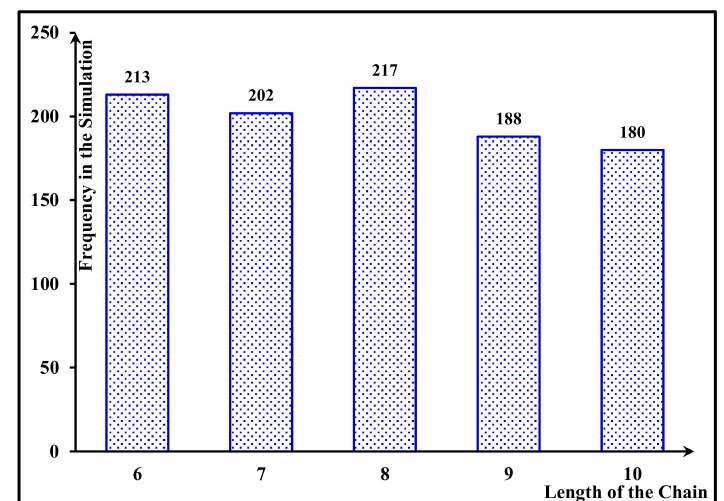
Figure 4. Frequency distribution of chain lengths.